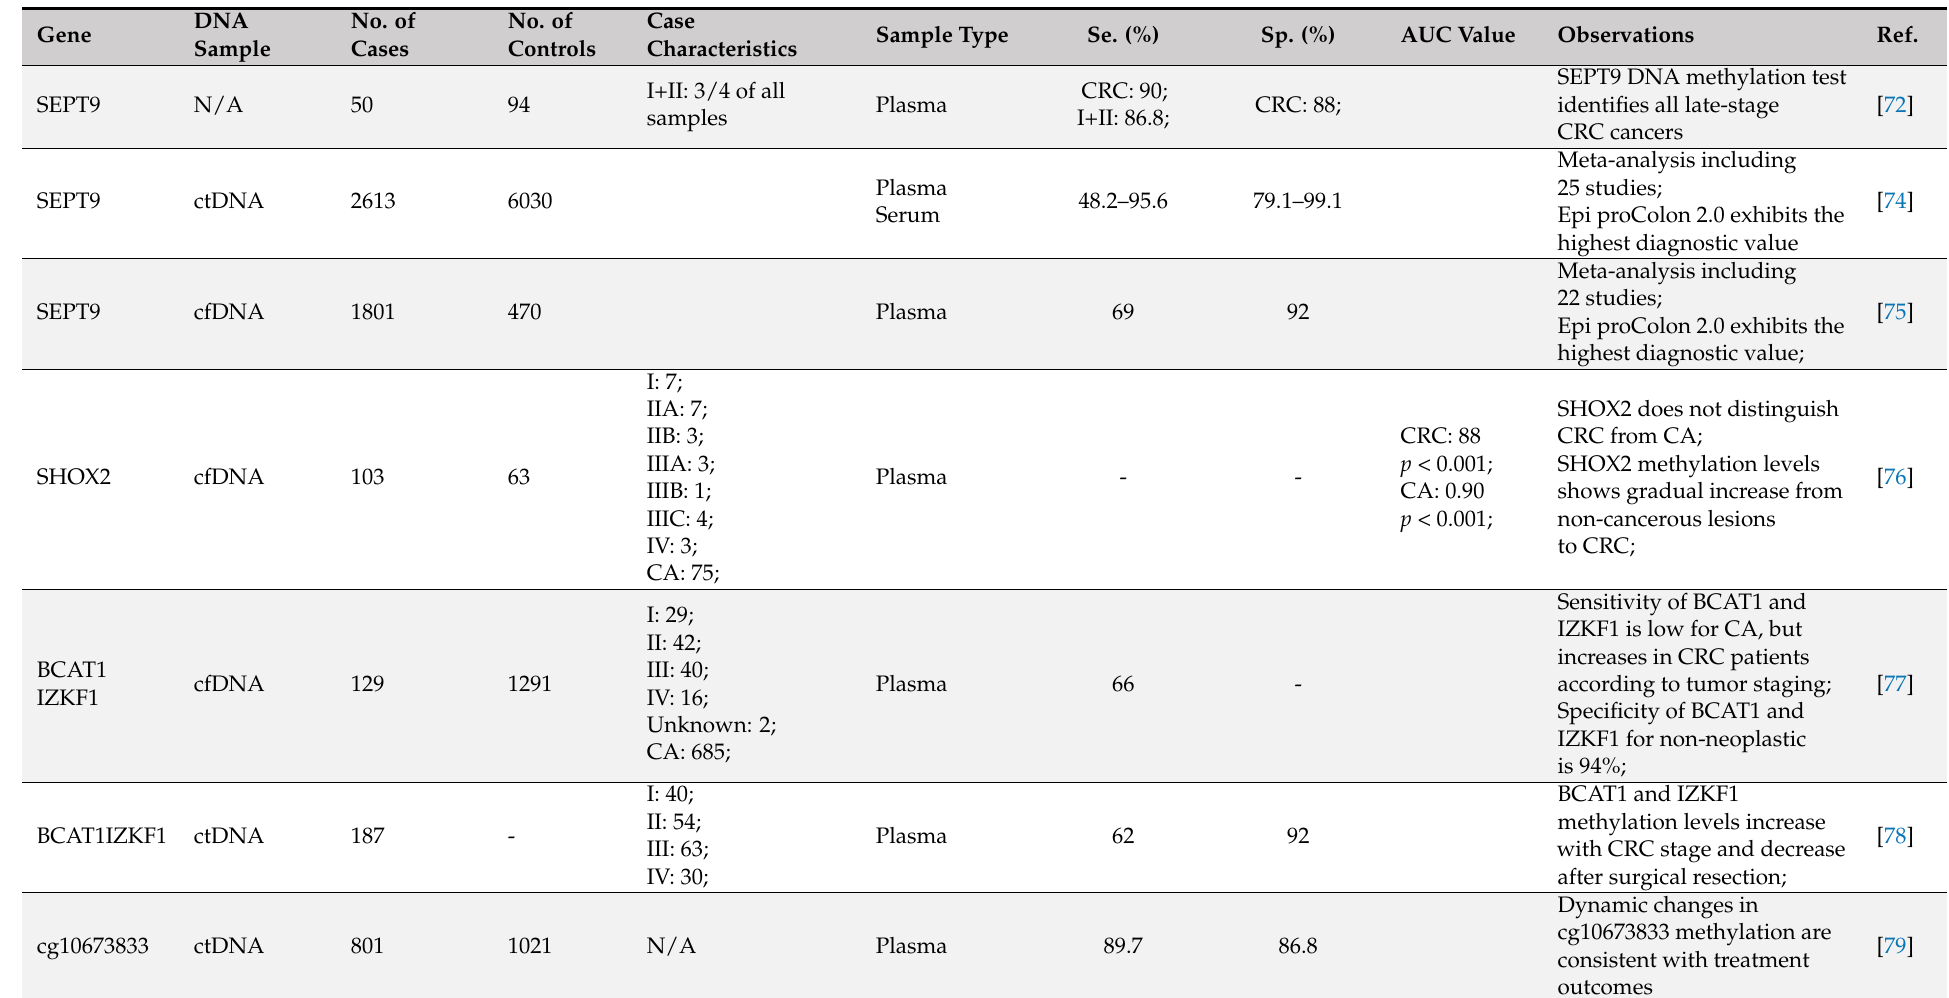
Table 1. Outline on methylation markers with confirmed validity in CRC screening and early